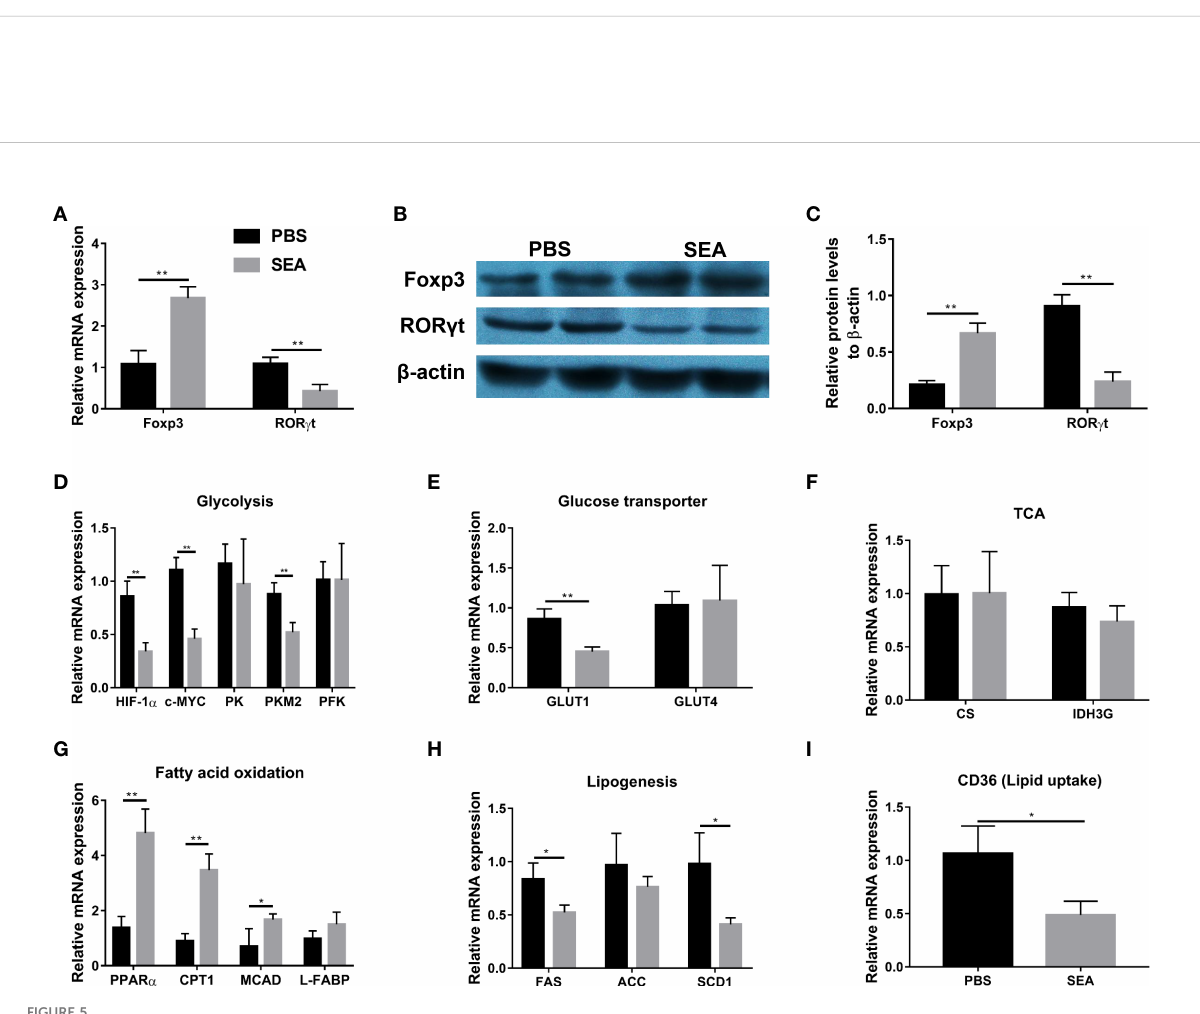
FIGURE 5 Modi fi cation of Treg and Th17 expansion by SEA via regulating glucose and lipid metabolism in vitro . Spleen naïve CD4+ T cells (CD4+ CD25- CD44- CD62L+) were sorted from the TNBS mice on the 5 th day post TNBS administration. T cells were cultured (3×10 5 cells/well) in 96-well plates coated with anti-CD3 mAb (5 m g/mL) and soluble anti-CD28 mAb (3 m g/mL) and kept in presence of IL-2 (100 U/mL). SEA (10 µg/mL) was added and PBS used as the control. Cells were cultured in RPMI-1640 Medium, 10% fetal calf serum, 2 mM L-glutamine, and 100 U/mL of Penicillin/Streptomycin for 3 days. The relative mRNA expression levels of Foxp3 and ROR g t (A) . The protein expressions of Foxp3 and ROR g t (B, C) . The relative mRNA expression levels of genes associated with glycolysis (D) , glucose transporter (E) , TCA (F) , fatty acid oxidation (G) , lipogenesis (H) and lipid uptake (I) were detected. Data are expressed as means ± SEMs based on 3 samples in each group and from 3 independent experiments. Asterisks mark signi fi cant differences among different groups (* P < 0.01, ** P <